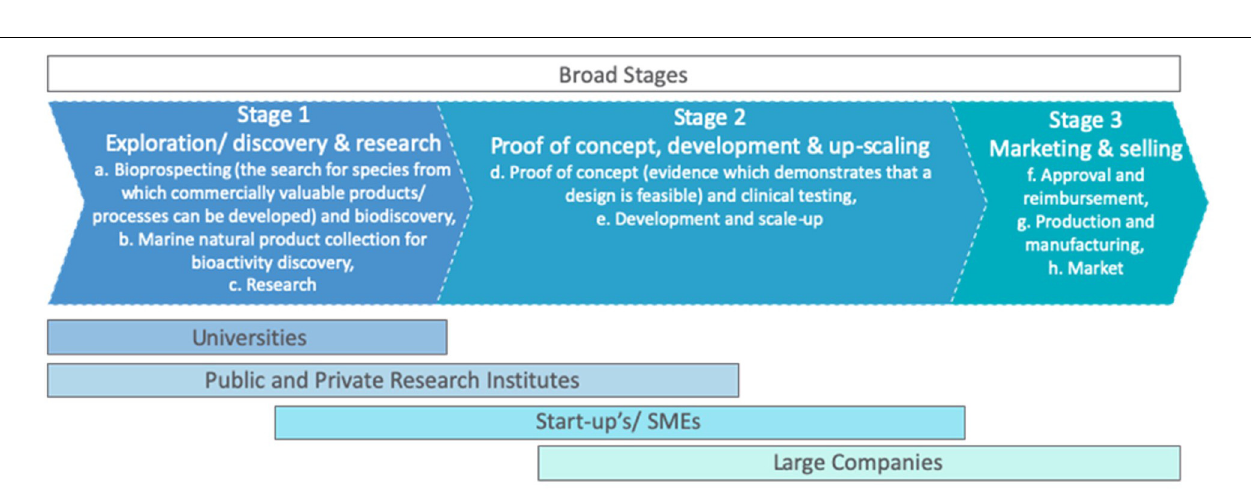
FIGURE 1 | Depiction of the marine bioresource value chain, from initial stages of discoveiy of a resource (left-hand side of the diagram) through to marketing and selling (right-hand side of the diagram) , adapted from Calado et al. (2018).